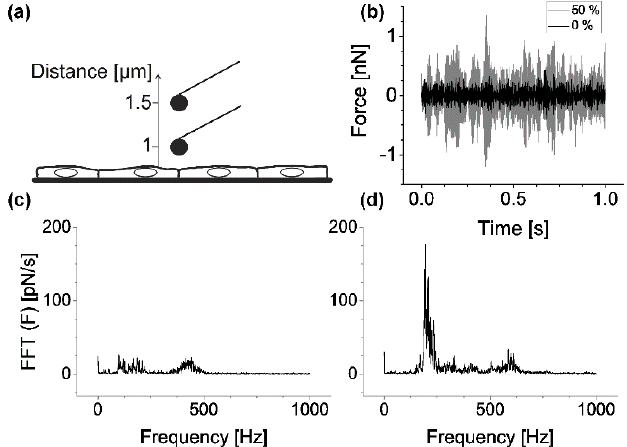
Figure 3. Background noise depends on chamber stretch. ( a ) Principle of mock force–distance curves recorded for noise analyses. AFM cantilever is approaching cell monolayer. ( b ) Exemplary force signals: black, strain 0%; gray, 50%. ( c ) Absolute values of a fast Fourier transformation (FFT) of the force signal at zero strain and ( d ) at 50% strain.